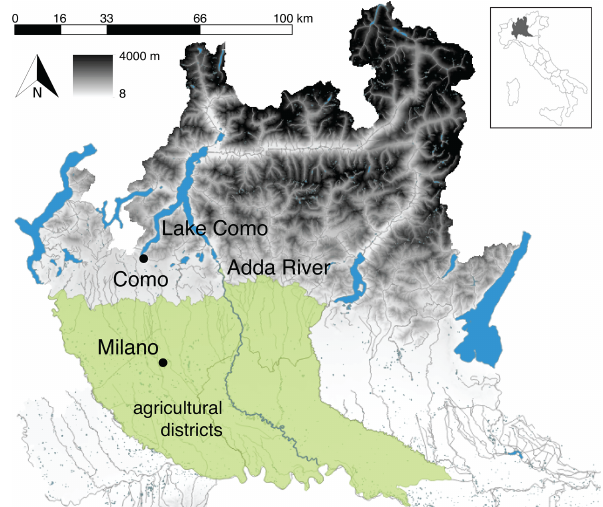
Figure 1. Map of the Lake Como basin. The map was generated via Q-GIS using layers from the Geoportal of Regione Lombardia (http: //www.geoportale.regione.lombardia.it/, last access: July 2016).